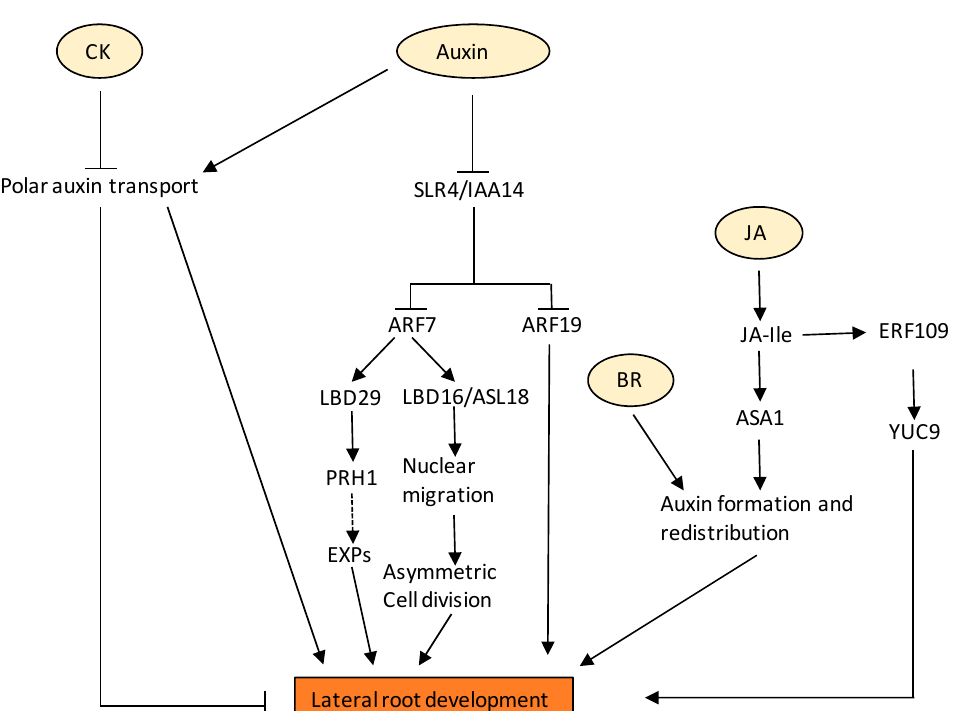
Figure 3. Regulation of LR development by various hormones and their crosstalk. Auxin via SLR4/ARF7-ARF9 signalling module promotes LR development. Auxin-induced expression of PRH1 is dependent on ARF7 and LBD29. PRH1 may promote LR development by regulating the expression of EXP genes that promote cell wall loosening. SLR4/ARF7-ARF9 signalling module also activates the expression of LBD16/ASL18 that are involved in the symmetry breaking of LR founder cells for LR initiation and primordium development. JA positively regulates lateral root formation by modulating auxin biosynthesis and homeostasis. JA induces the expression of ASA1 both through COI1 and ERF109. ERF109 also induces the expression of another auxin biosynthetic gene, YUC9 . BR regulates lateral root development by interacting with auxin. At low concentration, BR modulates auxin transport and promotes lateral root development. CK negatively regulates LR initiation and development by inhibiting auxin carriers. Solid black arrows indicate confirmed pathway. Dotted arrow indicates pathways for which there is little or no